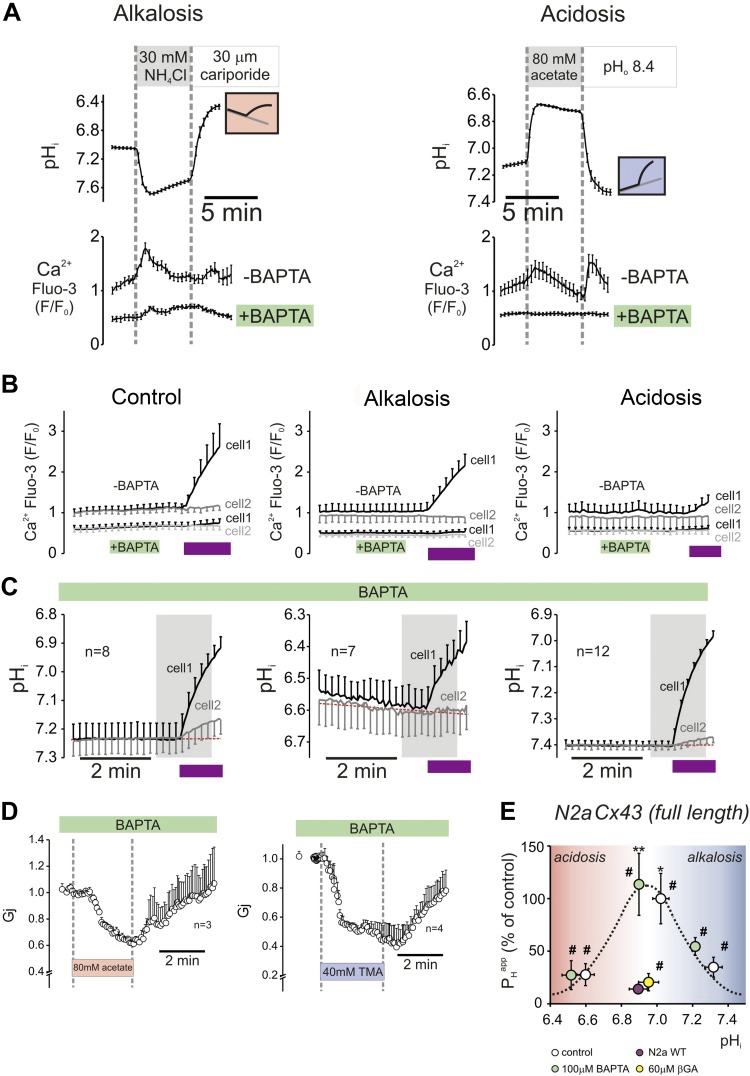
Ca2+ signals are not involved in the alkaline-gating mechanism. A) Prepulsing with 30 mM NH4Cl (left) or 80 mM acetate (right) normally increases [Ca2+] (Fluo3), but this is attenuated in cell pairs that are AM-loaded with 100 µM BAPTA. B) BAPTA also ablates Ca2+ response to H+ uncaging. C) BAPTA did not affect H+ ion permeability, nor its pHi dependence. Shaded regions correspond to the period we used to fit data using mathematical models. Purple bands correspond to the uncaging period (flash photolysis). D) Inclusion of 5 mM BAPTA in the pipette solution during whole-cell voltage-clamp experiments had no effect on Gj response to 80 mM acetate or 40 mM TMA. Controls to this experiment (BAPTA-free pipettes) are shown in Fig. 1. E) Comparison of PHapp calculations between control (white circles) and BAPTA (green circles) experiments. Also included are results from nontransfected N2a cells (red circle) and Cx43-transfected cells that were treated with 60 μM βGA (yellow circle). #Significantly different from 0.